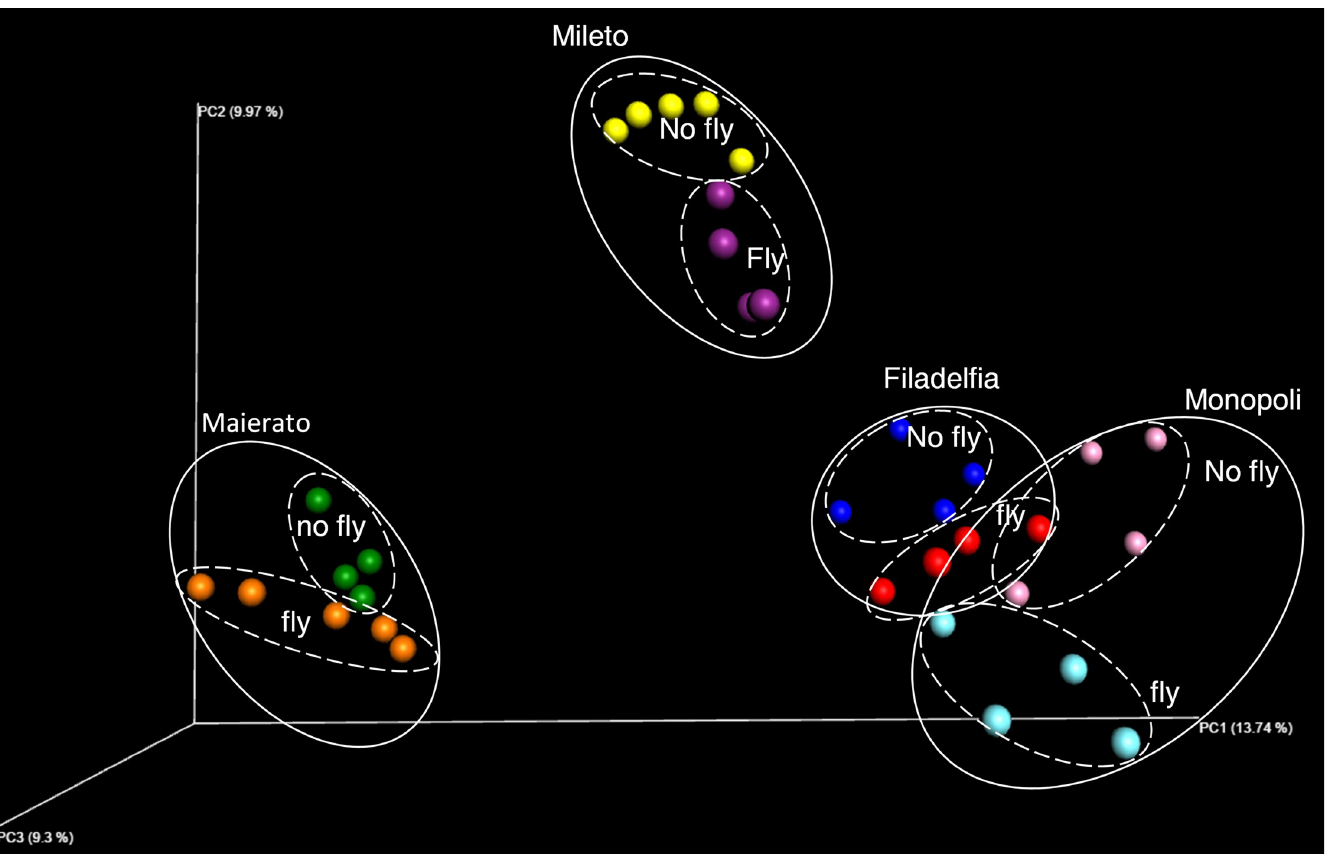
Fig 6. Principal coordinate analysis (PCoA) of the fungal communities associated with olive drupes infested (fly) or non-infested (no fly) by the olive fruit fly Bactrocera oleae and collected in the four studied localities (Monopli, Mileto, Filadelfia or Maierato).